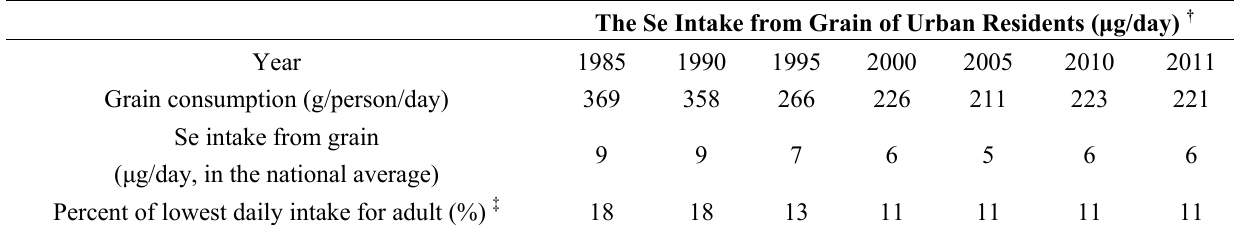
Table 4. The Se concentration of rice and Se intake from